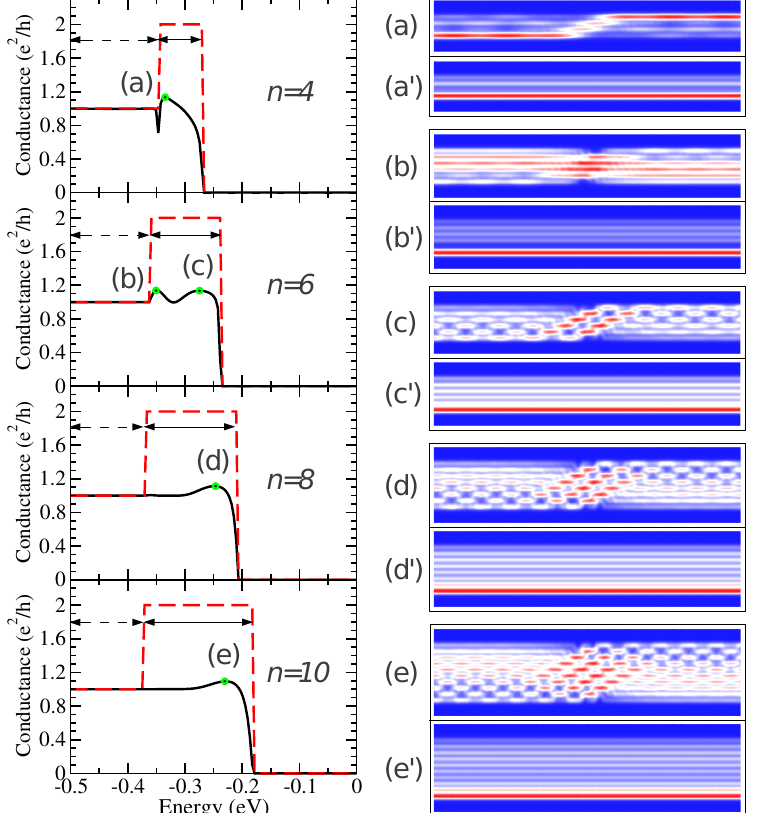
( Left ) Conductance for a given spin orientation in the AFM homojunction (red dashed lines) and heterojunction (black full lines) for the zGNR- n ( n = 4 , 6 , 8 , 10 ) systems. The energy ranges (I) and (II) correspond to the dashed and full double arrows, so that they present, respectively, one and two channels in the homojunction (see Figure 3). ( Right ) Local current plots for the peaks corresponding to the (primed) letters in the left panel for the heterojunction (homojunction). In these plots, dark blue corresponds to zero current, while red shows the places with maximal